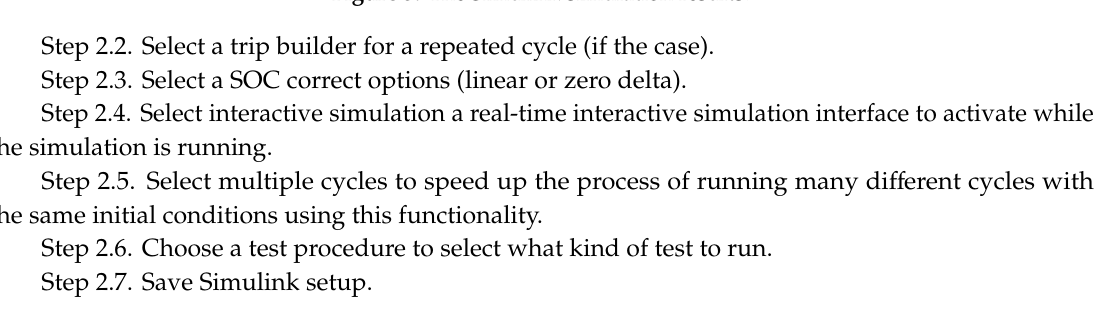
Figure 5. The Simulink simulation results.